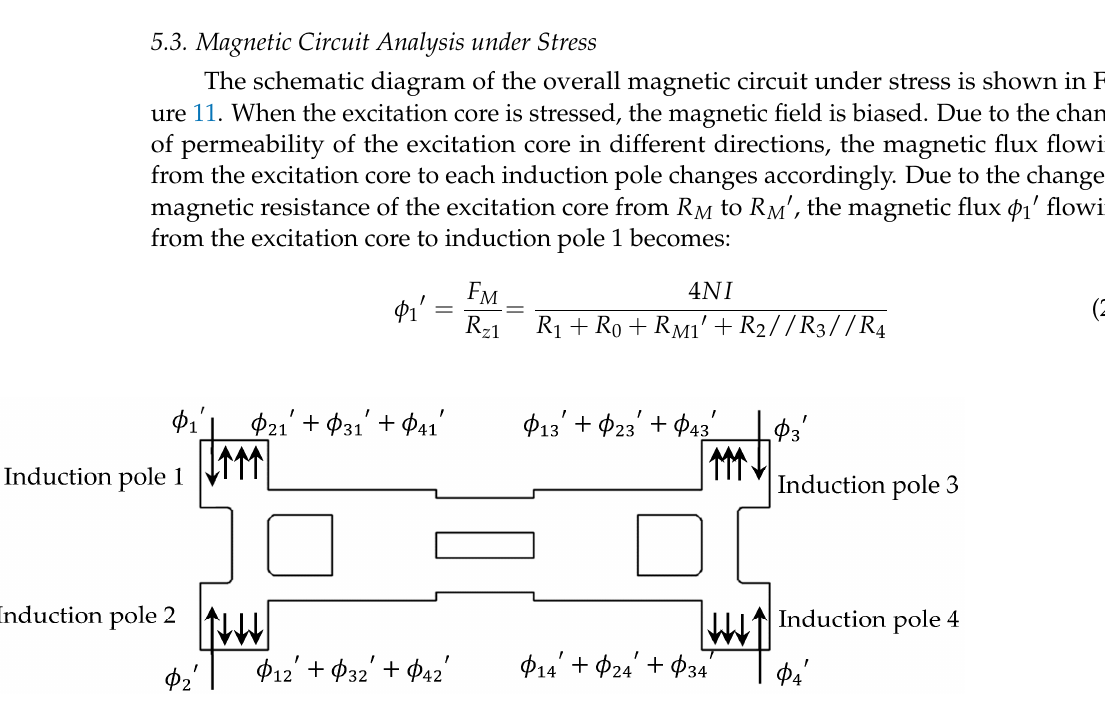
Figure 11. Schematic diagram of overall magnetic circuit under force.